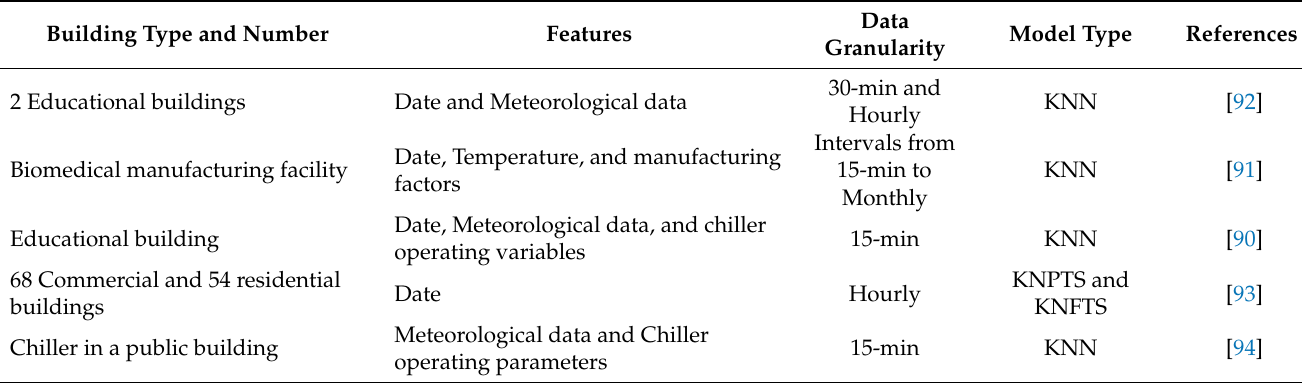
Table 6. Kernel regression cases that are applicable to M&V analysis and utilize real historical